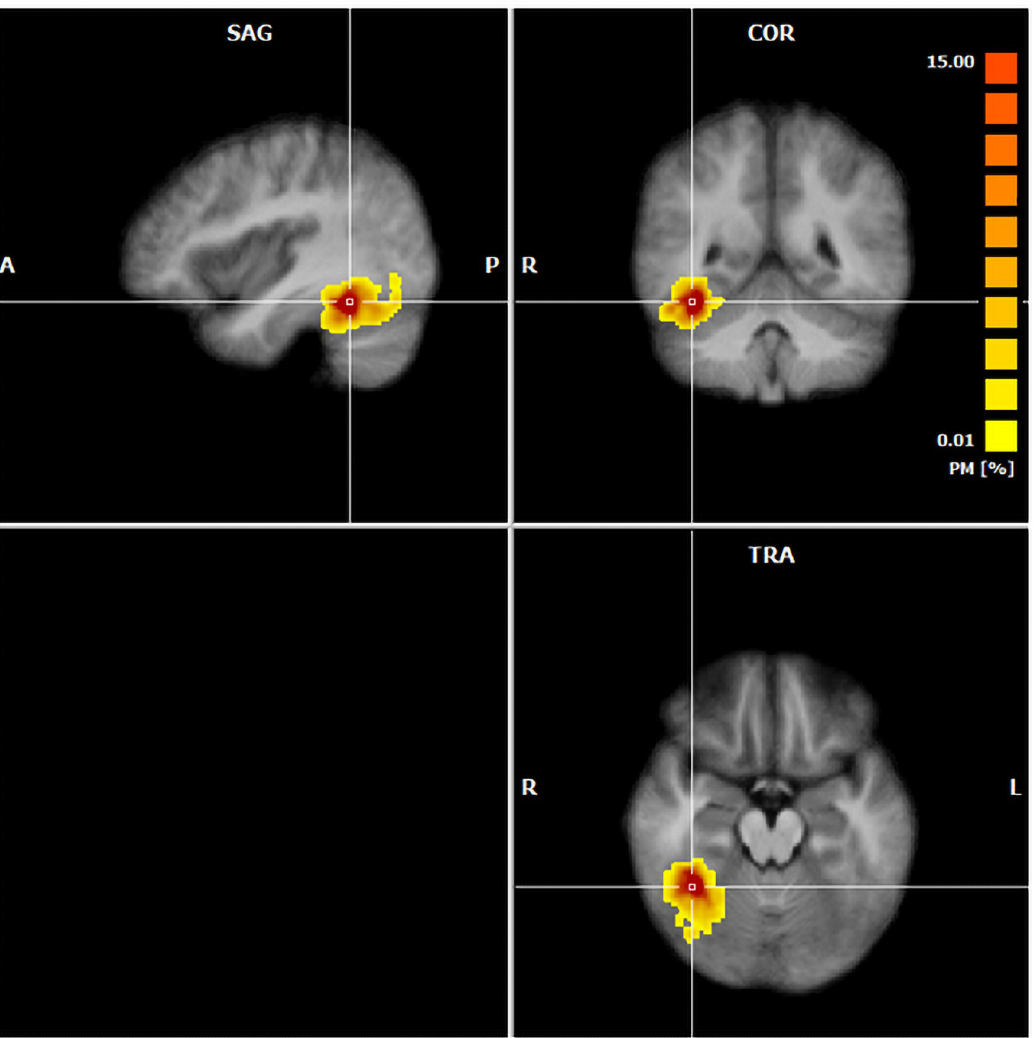
Fig 3. Probability map, showing the locations of the individual right FFA ROIs. Warmer colors indicate a higher proportion of ROIs in this voxel.